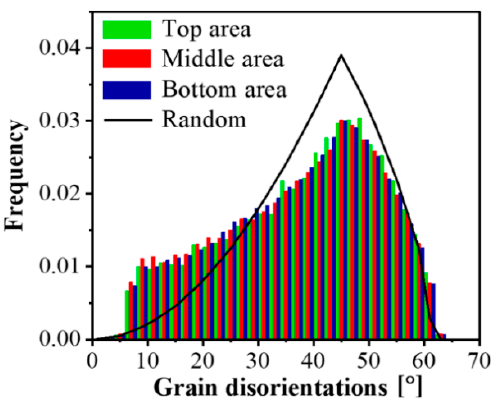
Figure 5. Next-neighbor grain disorientation distributions measured in the top, middle, and bot- tom areas of the Al-1050 produced